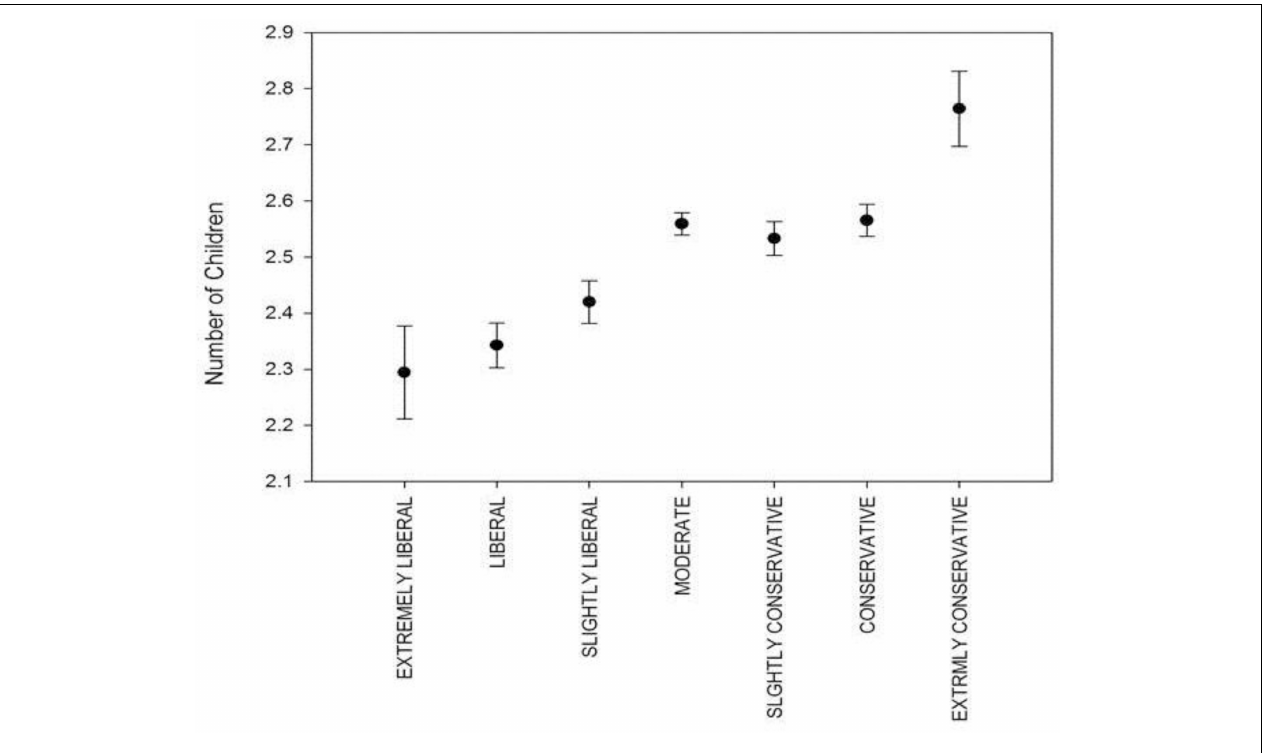
FIGURE 4 | GSS-data: political orientation and mean ( ± SE) number of children. TABLE 6 | GSS: linear mixed model of number of children on basis a Poisson error structure regressing on political orientation included as factor (most liberal as reference), age, sex, education (lowest education level “lower than high school” as reference), income, and frequency of attendance of religious services, with year of survey as random